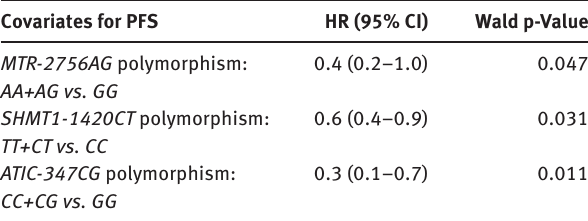
Table 3 Multivariate analysis.